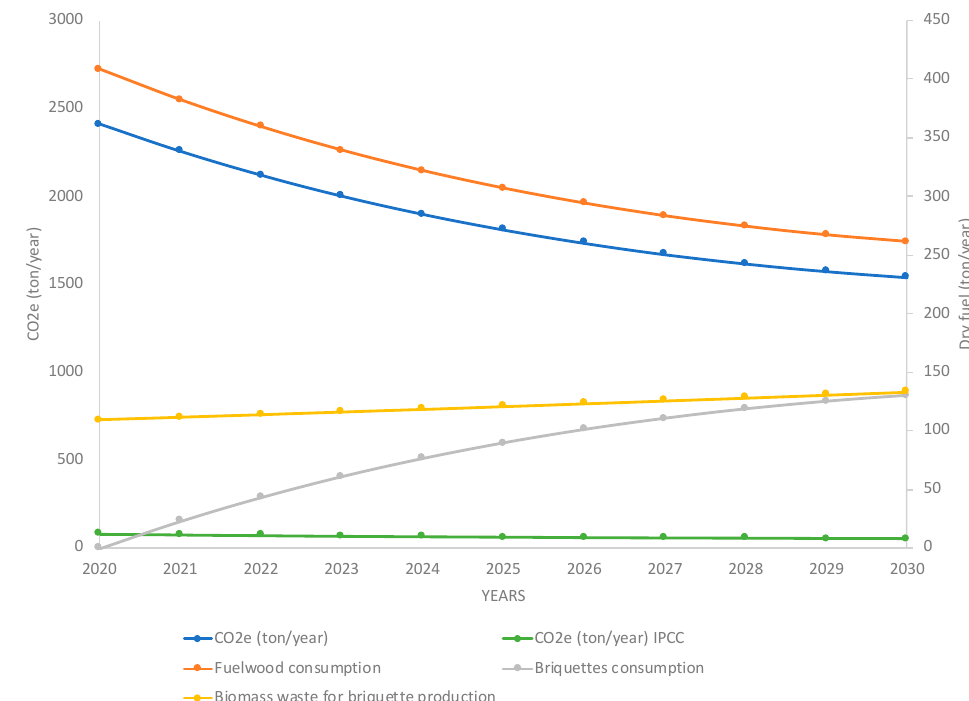
Figure 5. Fuel consumption scenario in San Francisco Pichátaro. Note: The annual population growth was assumed to be 4% [37,38] and the transition of open fire to improved cookstove was estimated to be 10% [20]. The calculation of CO 2 e (IPCC) considers CO 2 as carbon-neutral and considers only the contribution of CH 4 and N 2 O. N 2 O, which is typically associated with high temperature combustion, was not measured in our study and has been demonstrated to be a small fraction of biomass stove global warming commitments in prior studies [39]. The CO 2 e and briquettes consumption represent the gasification of briquettes for heating or boiling water. This scenario refers to the implementation of gasifiers.